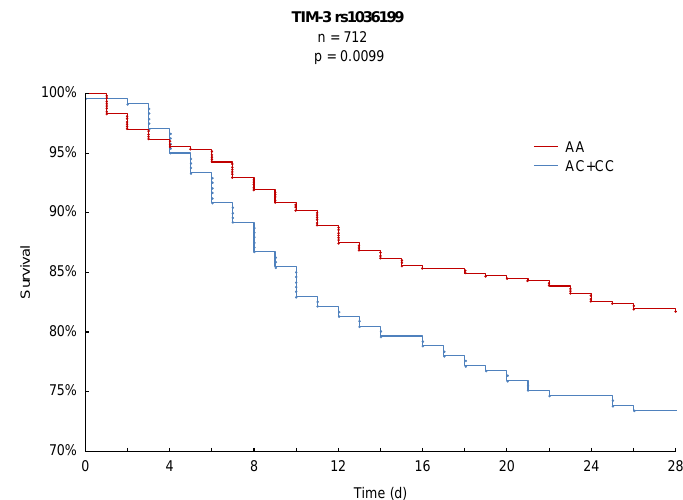
Figure 1. Kaplan–Meier 28-day survival analysis with respect to TIM-3 rs1036199. Int. J. Mol. Sci. 2020 , 21 , x FOR PEER REVIEW